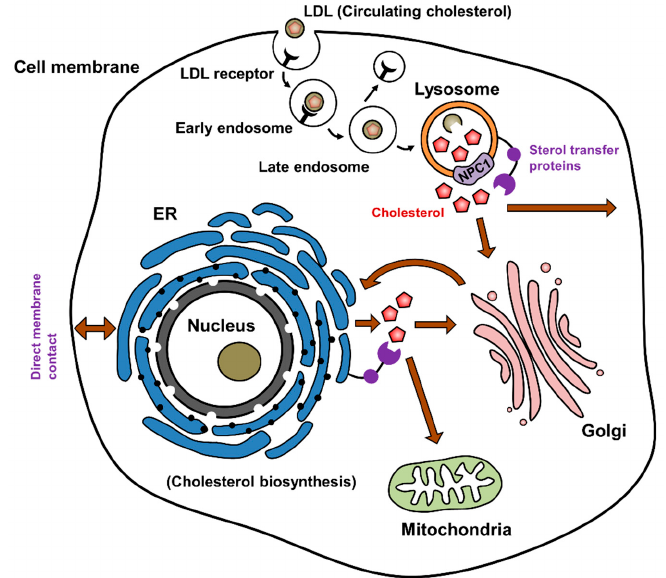
Figure 1. Intracellular cholesterol trafficking. Biosynthesized cholesterol from endoplasmic reticulum (ER) is delivered to the cell membrane directly or via the Golgi. Circulating cholesterol (low-density lipoprotein (LDL)-cholesterol) is delivered through the endosomal tra ffi cking system, where LDL binds to the LDL receptor in the clathrin-coated pits on the cell membrane and internalizes via endocytosis. The endosomes are then mature and are fused with lysosomes, where cholesterol is released from LDL and transported out from the endosomal system. Through anterograde (ER to Golgi) and retrograde (Golgi to ER) tra ffi cking, cholesterol is delivered to cellular organelles and plasma membrane. Inter-compartmental cholesterol delivery can be done via sterol transfer proteins, such as oxysterol binding protein (OSBP) and OSBP-related protein (ORP), or by membrane (vesicular) tra ffi cking along cytoskeletal proteins using kinesin or dynein